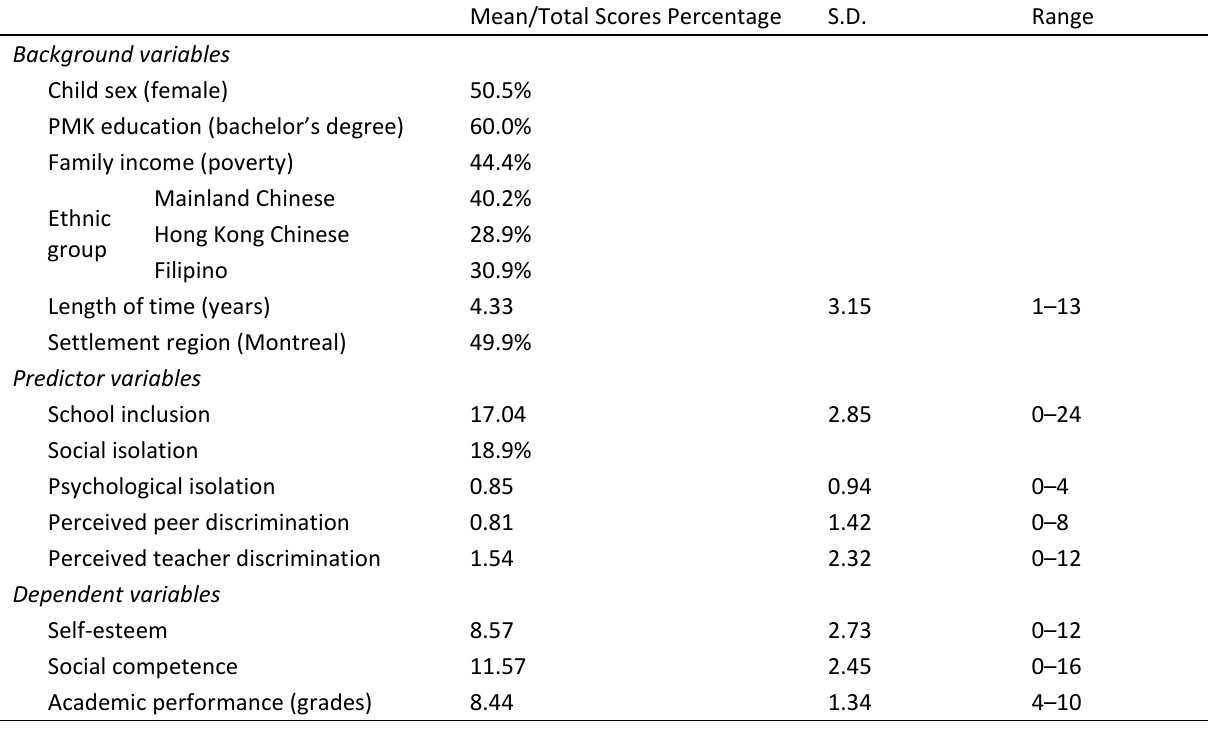
Table 1. Descriptive statistics of study